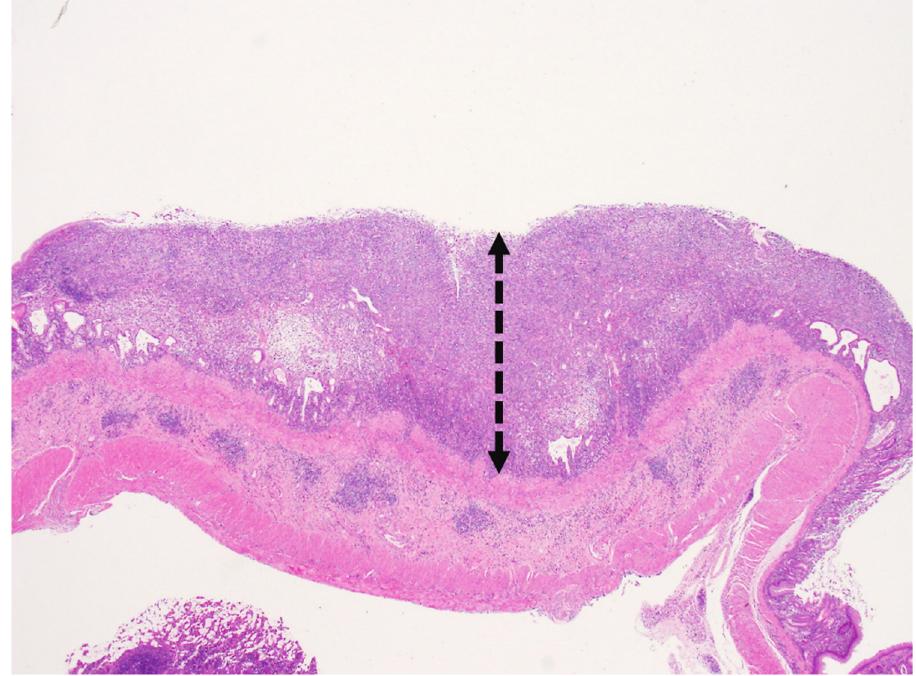
Figure 5. Gastric mast cell tumor, African dormouse, Hematoxylin and eosin. Focally and markedly thickened mucosa is expanded by an unencapsulated, infiltrative neoplasm with ulceration and dilation of the gastric glands (20×).